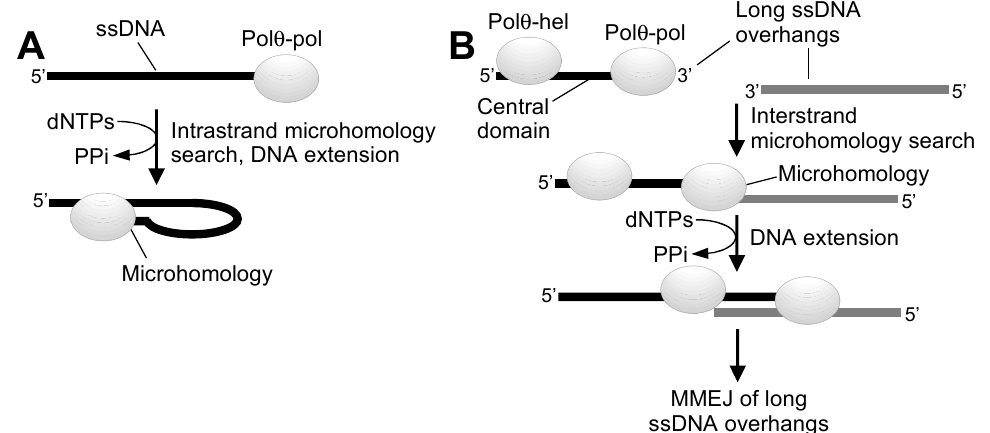
Figure 4. Full-length Pol θ promotes MMEJ of long 3 ′ ssDNA overhangs. ( A ) Pol θ -pol promotes snap-back replication on ssDNA by intramolecular microhomology search, transient microhomology annealing, and subsequent extension of the minimally paired 3 ′ terminal end of ssDNA. This activity suppresses MMEJ of long ssDNA overhangs by Pol θ -pol. ( B ) Full-length Pol θ performs MMEJ of long ssDNA. Covalent attachment of Pol θ -hel to Pol θ -pol through the Pol θ central domain or a short peptide linker suppresses intramolecular microhomology search and snap-back replication, which results in promoting intermolecular microhomology search and subsequent MMEJ.